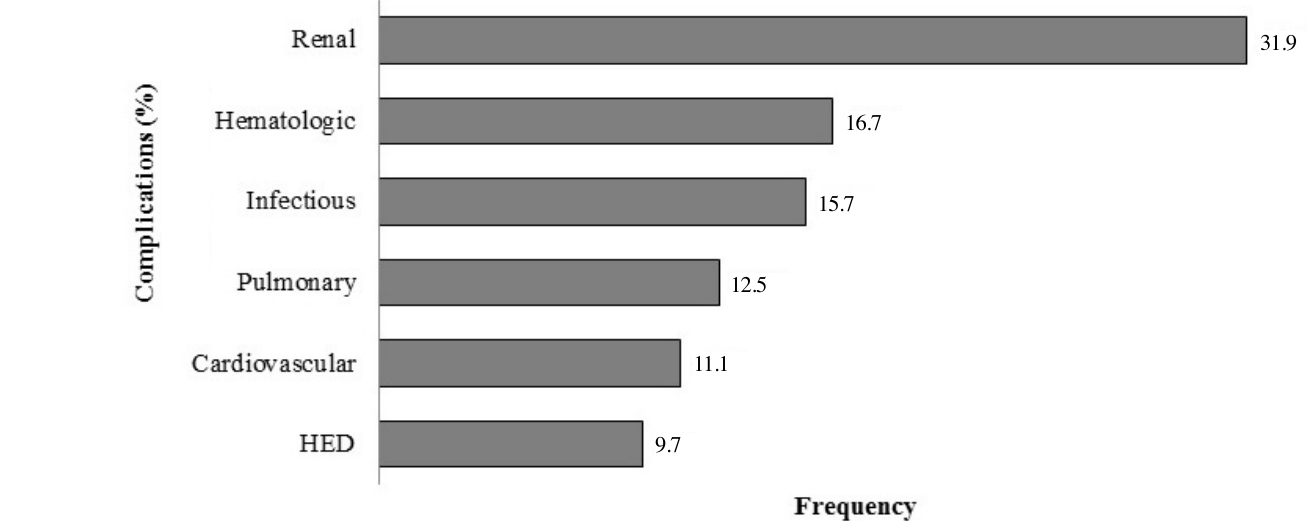
Fig. 1 - Distribution of clinical complications found in the postoperative period of major elective cardiac surgeries. HED=hydroelectrolytic Table 2. Clinical, anthropometric, biochemical and postoperative features of patients undergoing surgical procedure. Variables Mean Median Standard deviation